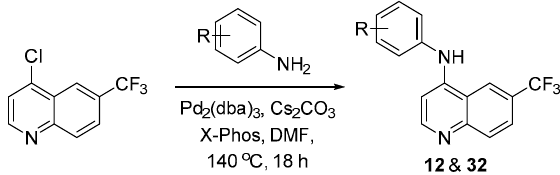
Scheme 2. General Buchwald-Hartwig cross-coupling procedure.